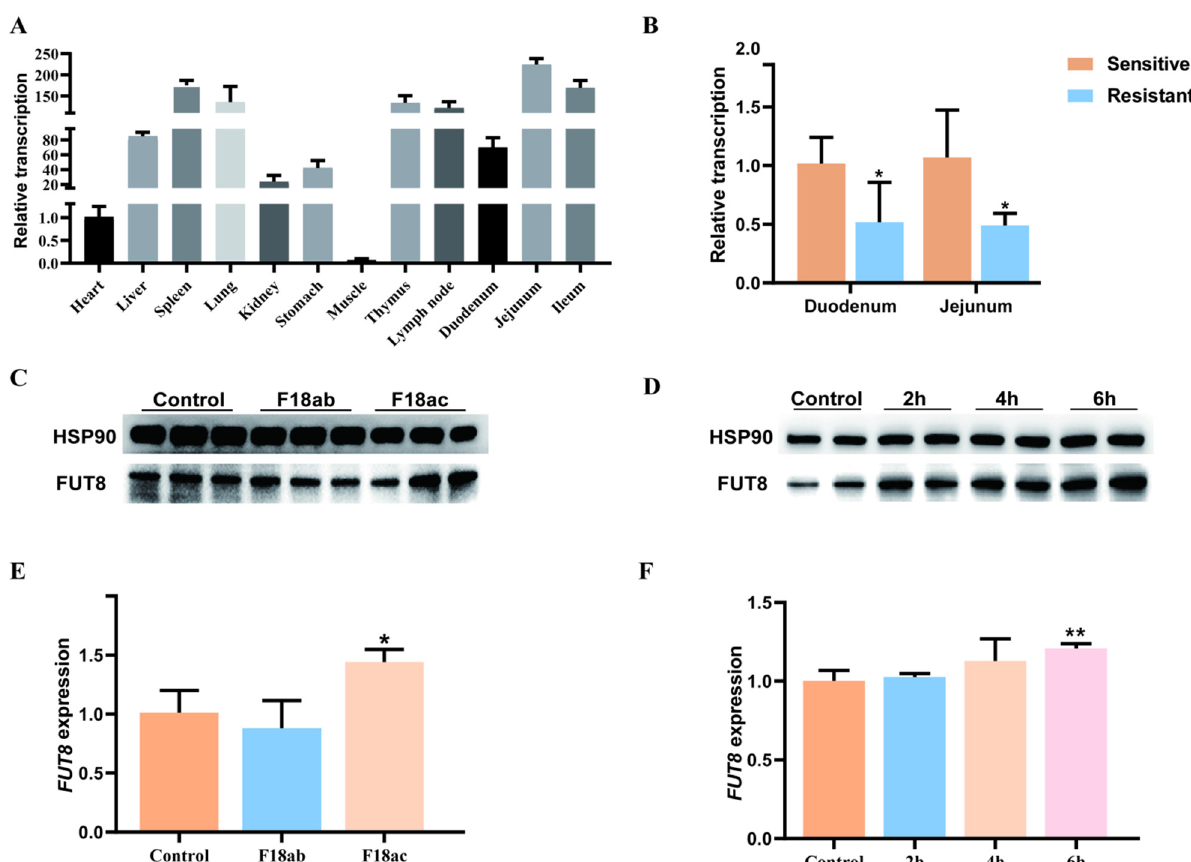
Figure 1. The relationship between the expression of FUT8 and E. coli infection was analyzed at the tissue and cell levels. ( A ) Expression of the FUT8 gene in 12 tissues of 35-day-old Meishan pigs. ( B ) Differential expression analysis of the FUT8 gene in intestinal tissues between E. coli F18-resistant and -sensitive Meishan piglets. ( C ) Expression levels of FUT8 in IPEC-J2 cells with E. coli infection were determined by Western blotting. ( D ) FUT8 expression analysis in IPEC-J2 cells was determined using Western blotting, which was induced by 1 µg/mL LPS at 0 h, 2 h, 4 h, and 6 h. ( E ) Expression of FUT8 in IPEC-J2 cells with E. coli infection was determined by RT-qPCR testing. ( F ) FUT8 expression in IPEC-J2 cells with 1 µg/mL LPS at 0 h, 2 h, 4 h, and 6 h induction was determined using RT-qPCR testing. * Represents a significant difference ( p < 0.05) and ** represents an extremely significant difference ( p < 0.01).